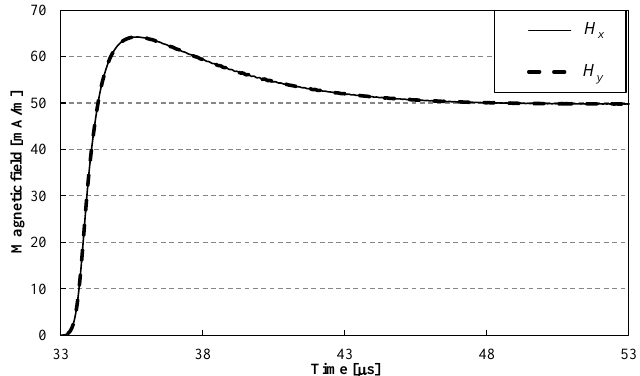
Figure 4. FDTD-computed waveforms of H x and H y at an observation point at (7080 m, 7080 m) for a lightning strike to a flat, perfectly-conducting ground (TL model, v = 150 m/μs).